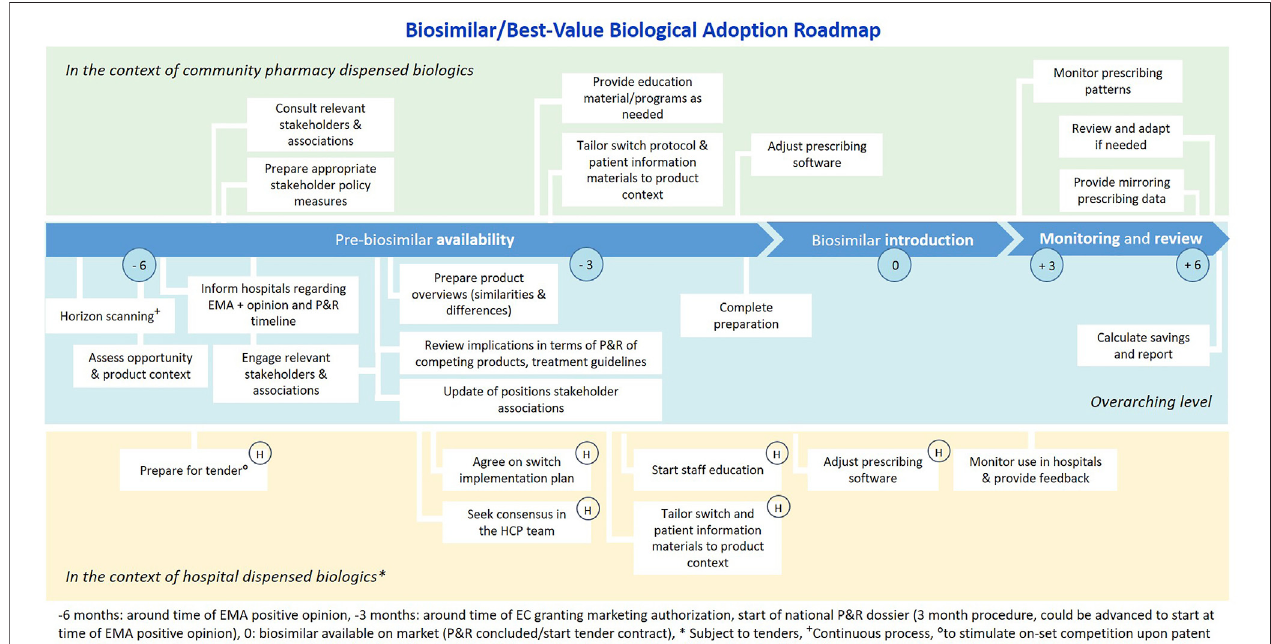
FIGURE 3 | Biosimilar/Best-Value Biological Adoption Roadmap, relevant for the Belgian context. Legend: Figuredeveloped based on the Cancer Vanguard NHS Biosimilar Adoption Process Timeline (The Cancer Vanguard Project, 2017), applied and tailored to the Belgian context